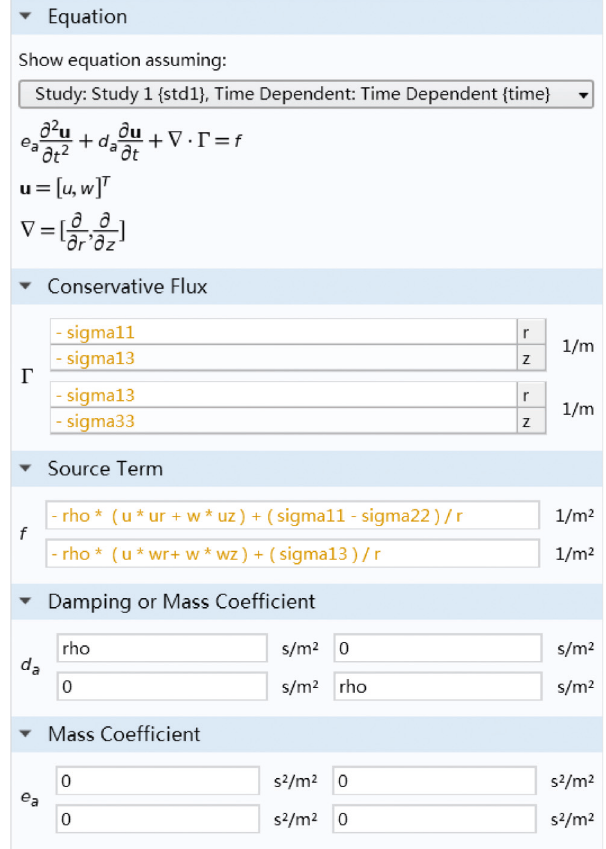
Figure 6: Input of momentum conservation equation in COMSOL.